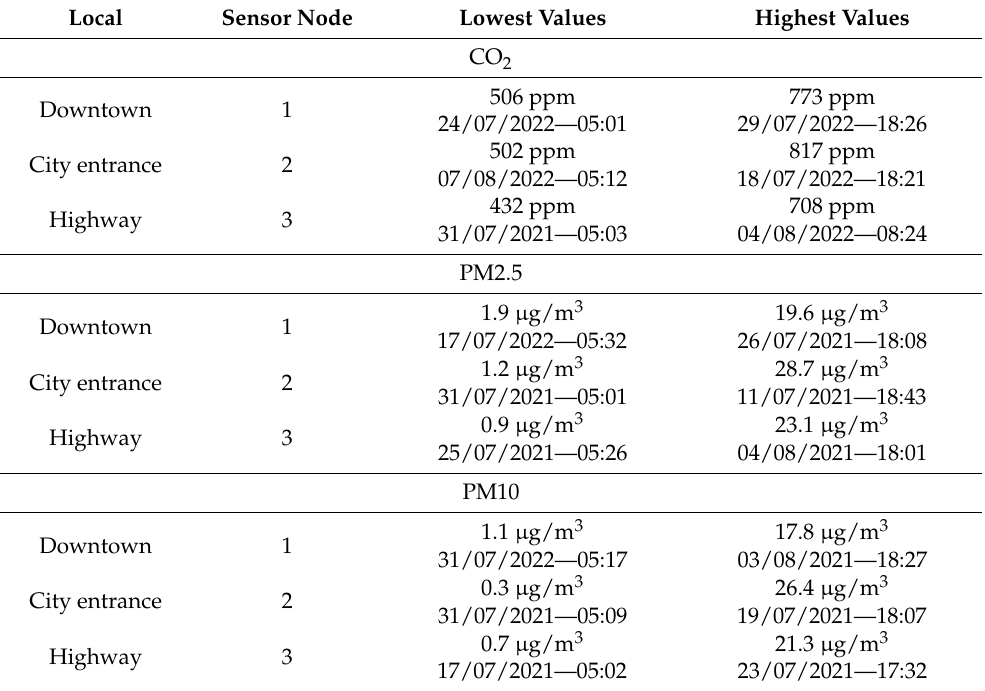
Table 1. The lowest and highest CO 2 , PM2.5, and PM10 concentration values were obtained in the three monitored locations during the 4-week